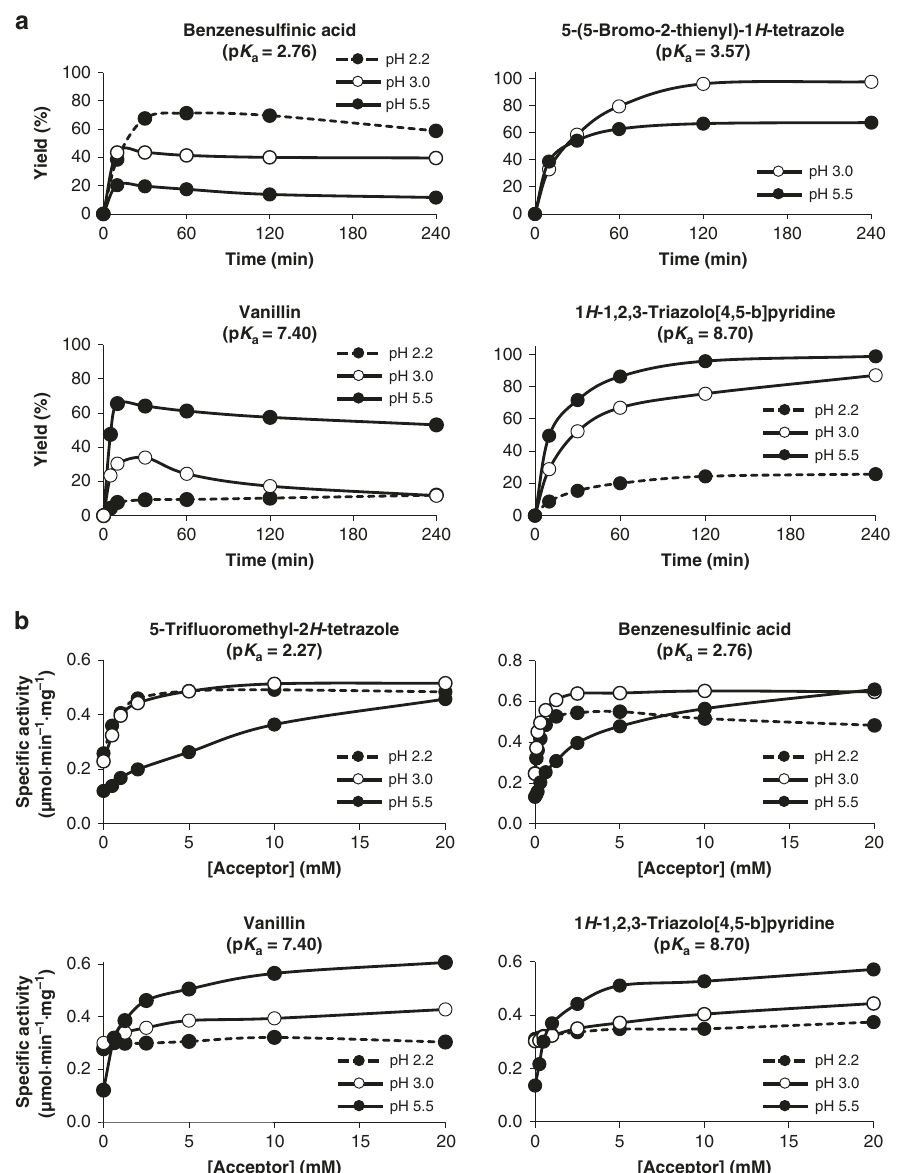
Fig. 4 Relationship between p K a and pH with the activity of rBxTW1-E495A. a Yield of acceptor conversion (%) into a xylosyl derivative in the presence of donor excess. The initial donor/acceptor ratio was 2/1 (mole/mole) and the acceptor conversion was determined by HPLC at different time intervals for 4 h. b Ligase activity response assay for each acceptor. The effect of each acceptor on the activity of rBxTW1-E495A was assayed over a range of acceptor concentrations. β -Xylosidase activity was determined spectrophotometrically using p NPX as substrate. Determined pro fi les are represented by a dashed line and black circles for pH 2.2, by a continuous line and white circles for pH 3.0 and by a continuous line and black circles for pH 5.5. Mean values are shown together with the corresponding standard error ( n = 3 independent experiments). Source data are provided as a Source Data fi